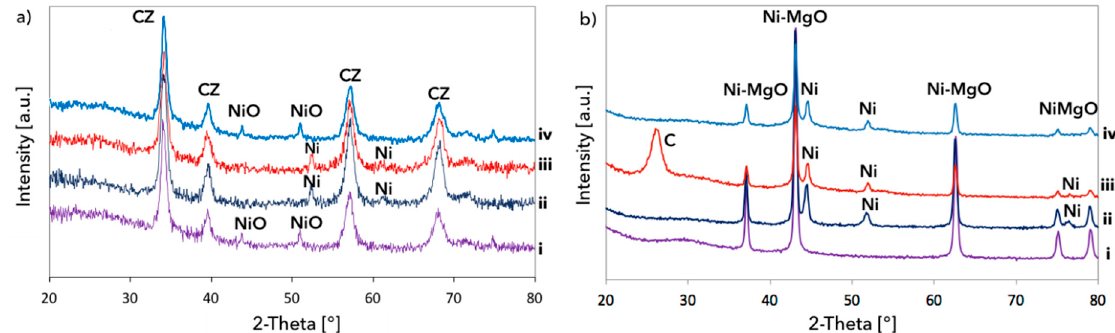
Figure 8. XRD for ( a ) Ni/CeZrO 2 and ( b ) Ni-MgO: (i) fresh, (ii) pre-reduced in H 2 , (iii) after CH 4 decomposition, (iv) after subsequent regeneration with H 2 O. The peaks of the CeZrO 2 phase in ( a ) were denoted “CZ”.